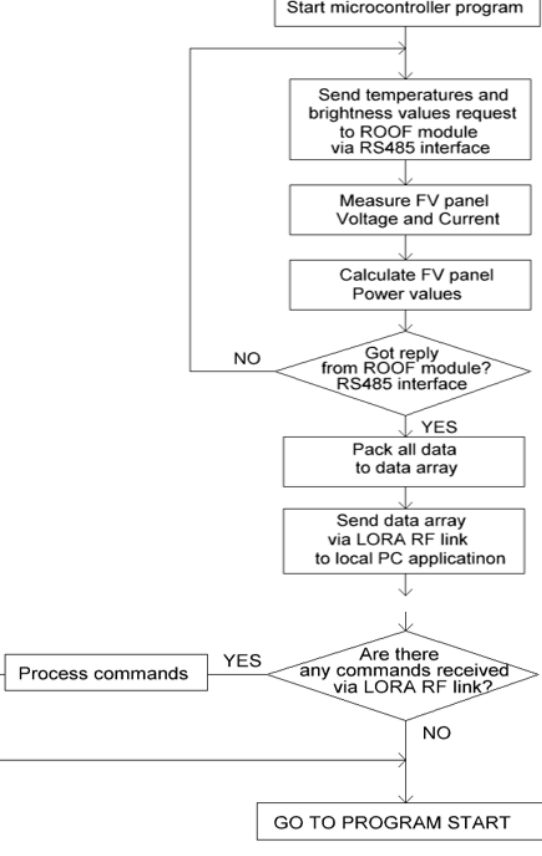
Figure 3. Algorithm scheme of the program code for the central controller to monitor and transmit the parameters of the solar power plant and the environment.